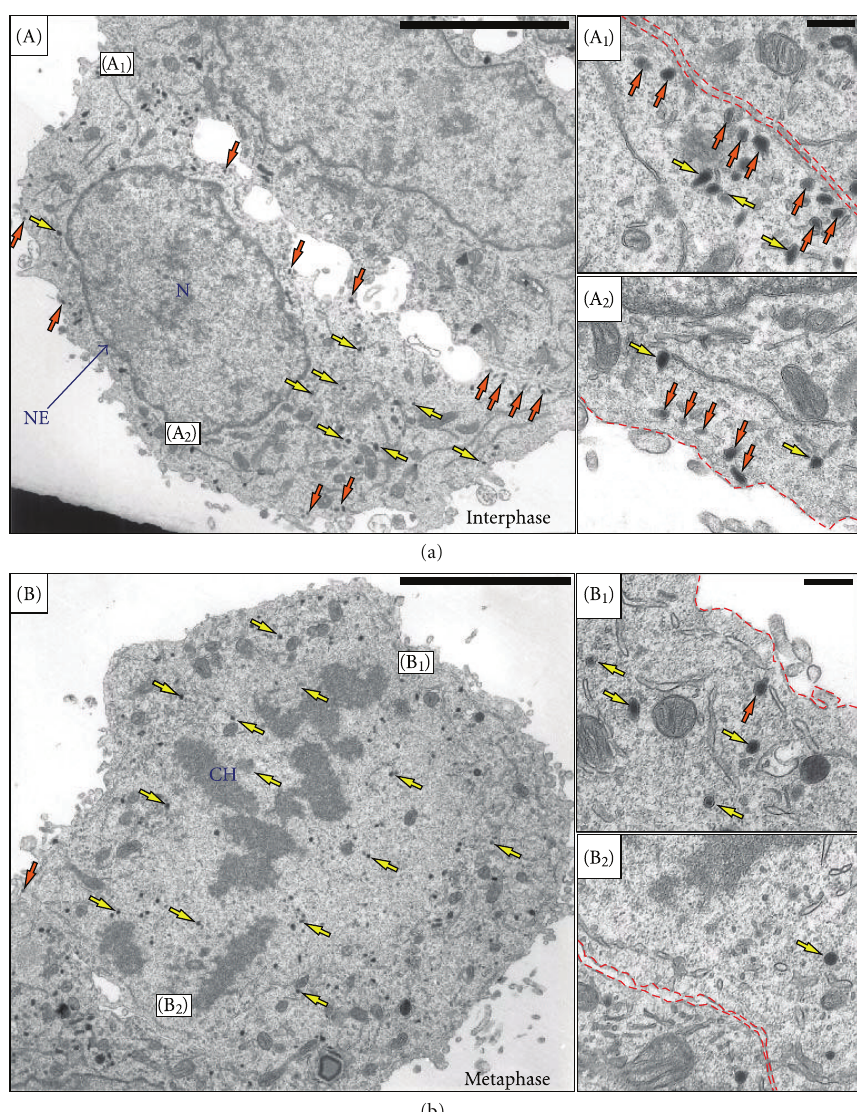
Figure 1: Ultrastructural analysis of the distribution of SGs in interphase and metaphase PC12 cells. (a) A typical interphase PC12 cell. The majority of SGs (size range of 80 to 150 nm) is peripherally localized (orange arrows). (b) A PC12 cell in metaphase. Almost all SGs are homogeneously distributed in the cytoplasm (yellow arrows), whereas peripheral SGs are rarely observed (orange arrows). Magnifications of the indicated regions in the main images (boxes in (A) and (B)) are shown on the right ((A 1 ), (A 2 ), (B 1 ), and (B 2 )). The red dashed lines indicate the cell boundaries. N, nucleus; CH, chromosomes. Scale bars, main images 5 μ m, magnified images,